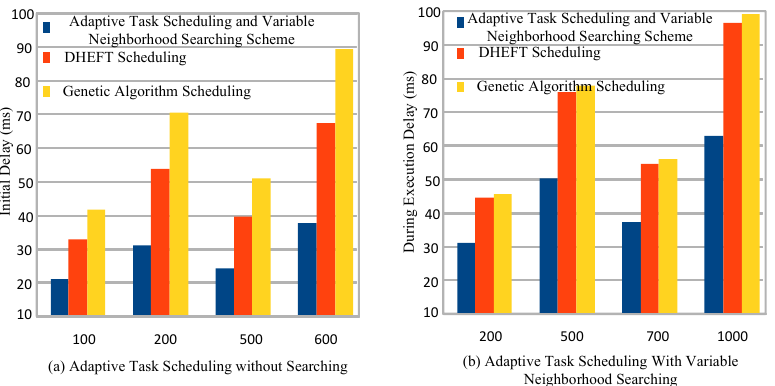
Figure 7. Adaptive task-scheduling and neighborhood-searching scheme for workflow